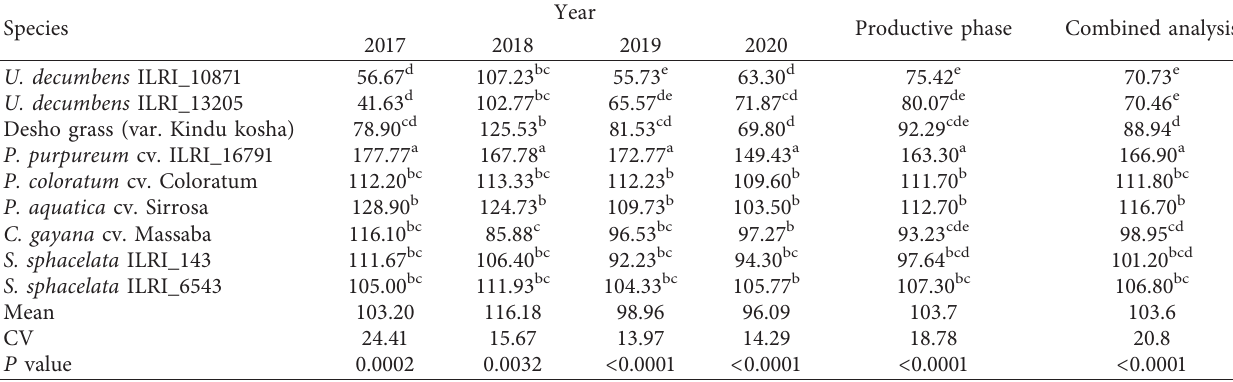
Table 4: Plant height (cm) of perennial forage grass species evaluated under supplementary